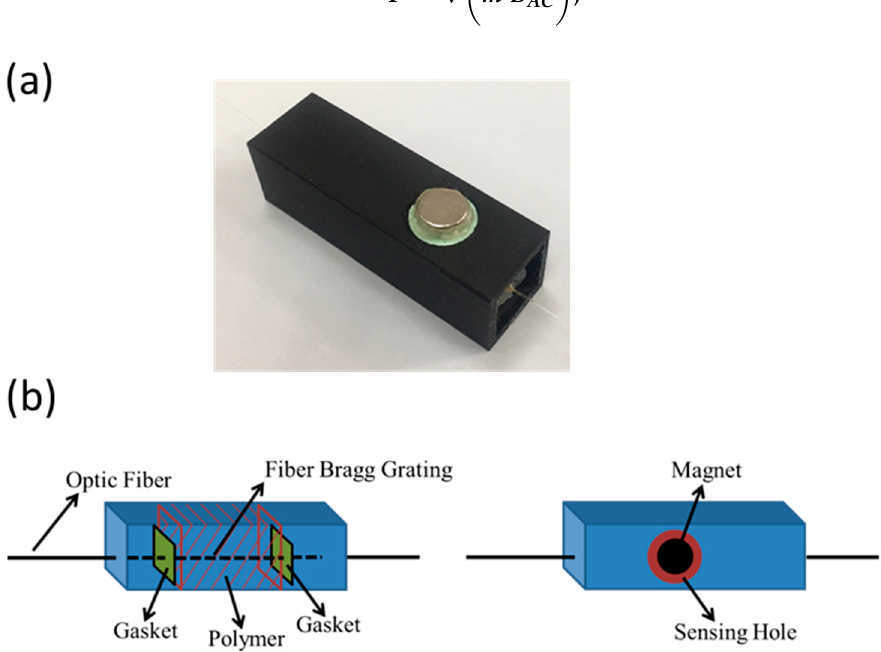
Figure 1. FBG AC magnetic sensor. ( a ) picture of the sensor; ( b ) the design structure of low-frequency magnetic field sensor.